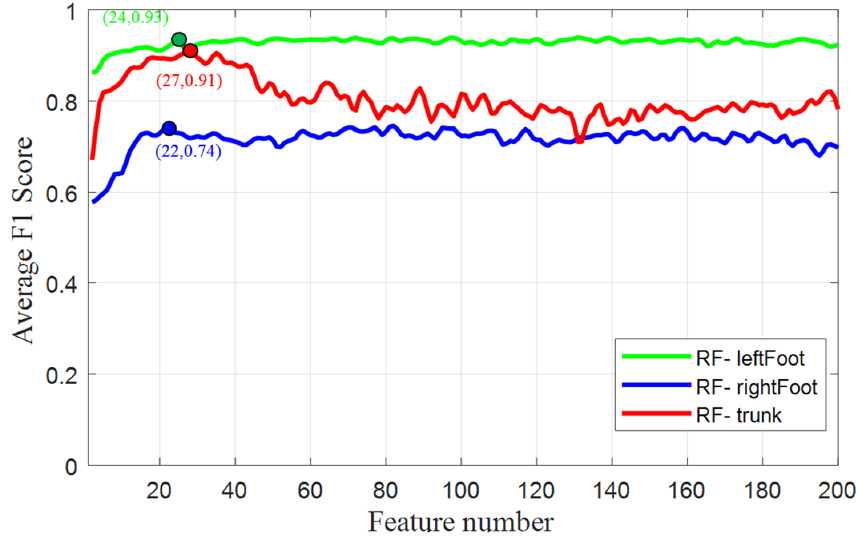
Figure 6. Average (cid:1832)1 (cid:1871)(cid:1855)(cid:1867)(cid:1870)(cid:1857) vs. feature number. Figure 6. Average F 1 score vs. feature